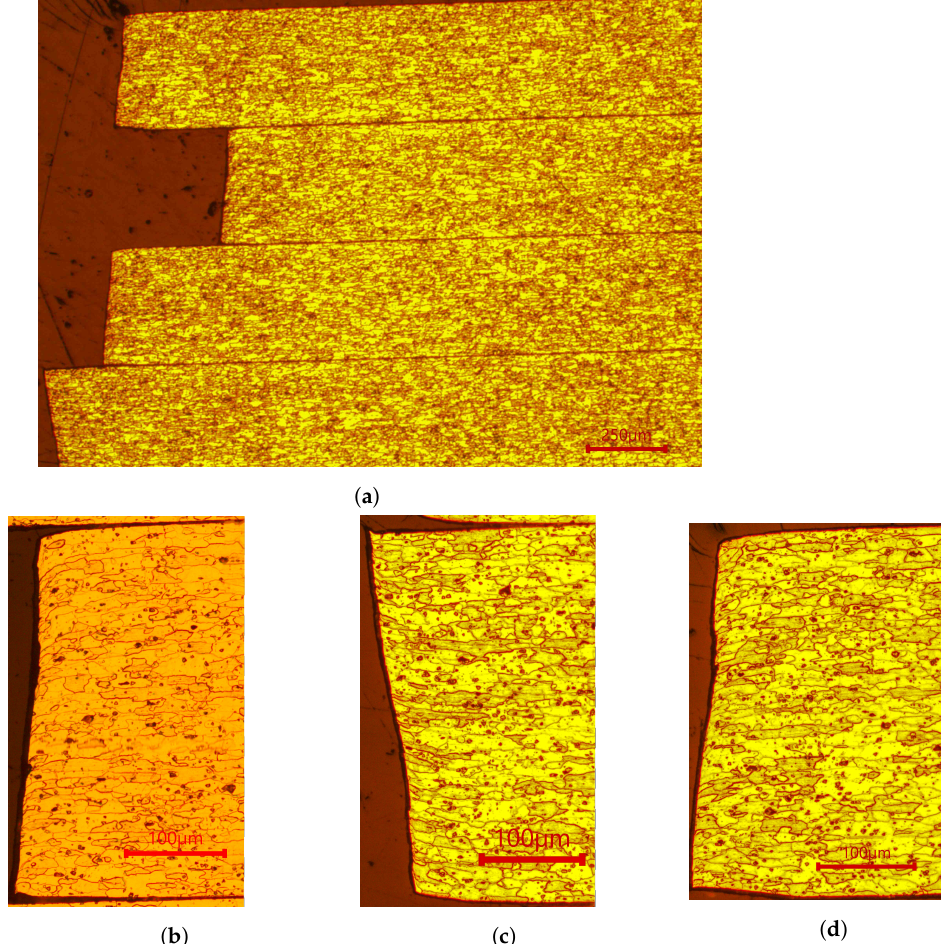
Figure 6. Microstructure of AA7075 sheets after shear cutting; ( a ) image of several samples, ( b – d ) close-up images of select